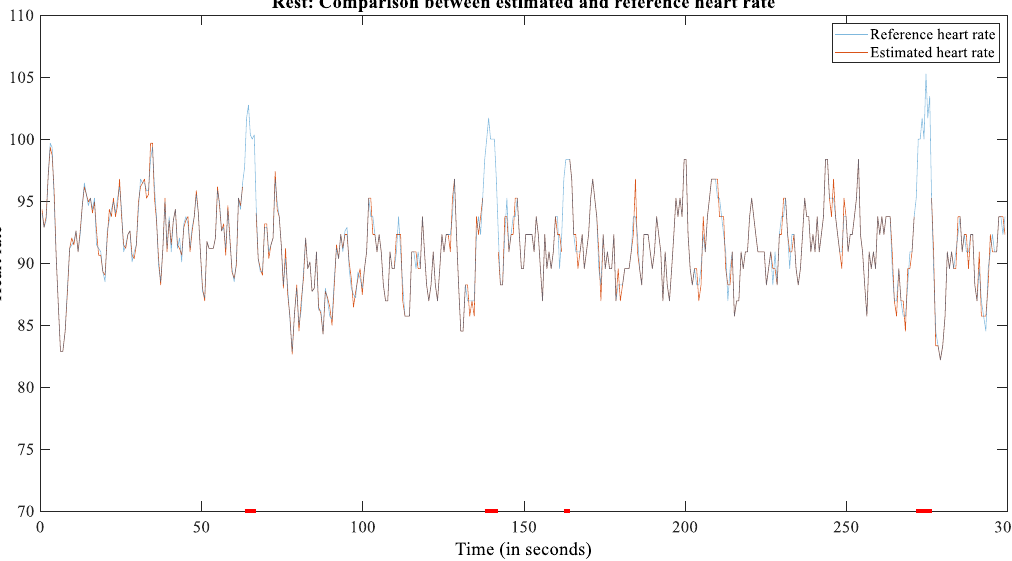
Figure 5. The plot of reference and estimated HR for subject 2209 during rest.